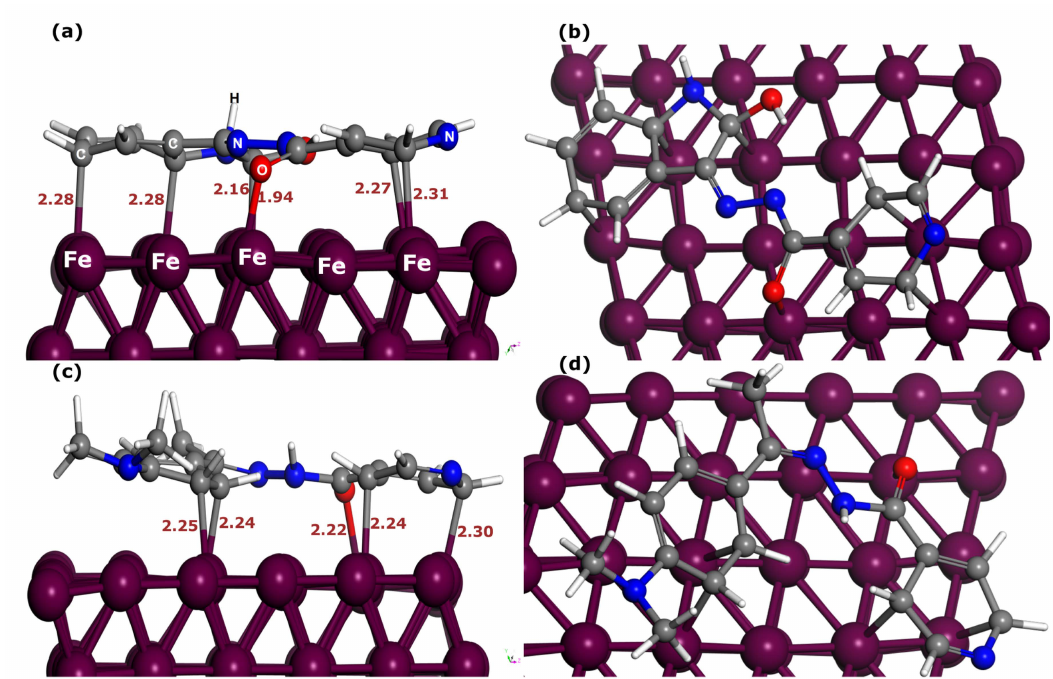
Figure 8. Optimized adsorption geometries of ( a , b ) OHEI and ( c , d ) MAPEI on Fe (110) surface obtained via DFTB calculations; ( b , c ): top views.